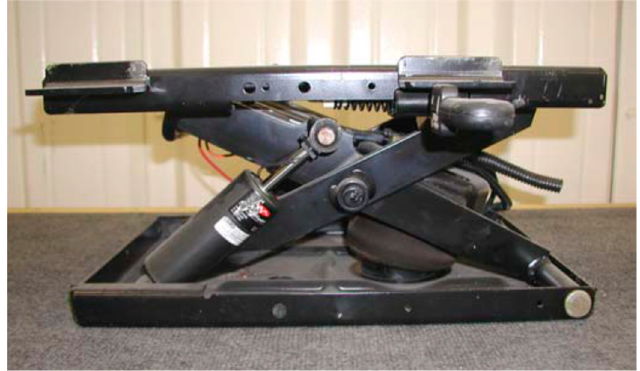
Figure 2. Passive seating suspension system prototype [19].